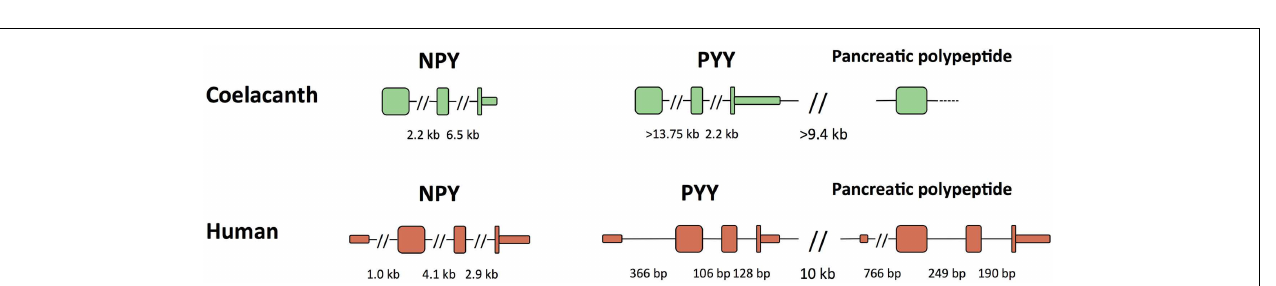
FIGURE 5 | Exon organization of the three coelacanth NPY-family peptide genes and their orthologs human peptide genes. All genes are shown in the 5 (cid:48) -to-3 (cid:48) direction. PYY and pancreatic polypeptide are located adjacent to each other and have the same orientation on the chromosome, thus a “head-to-tail” orientation. Exons are shown as tall boxes for the coding region and low boxes for the 5 (cid:48) - and 3 (cid:48) -untranslated regions where known.The